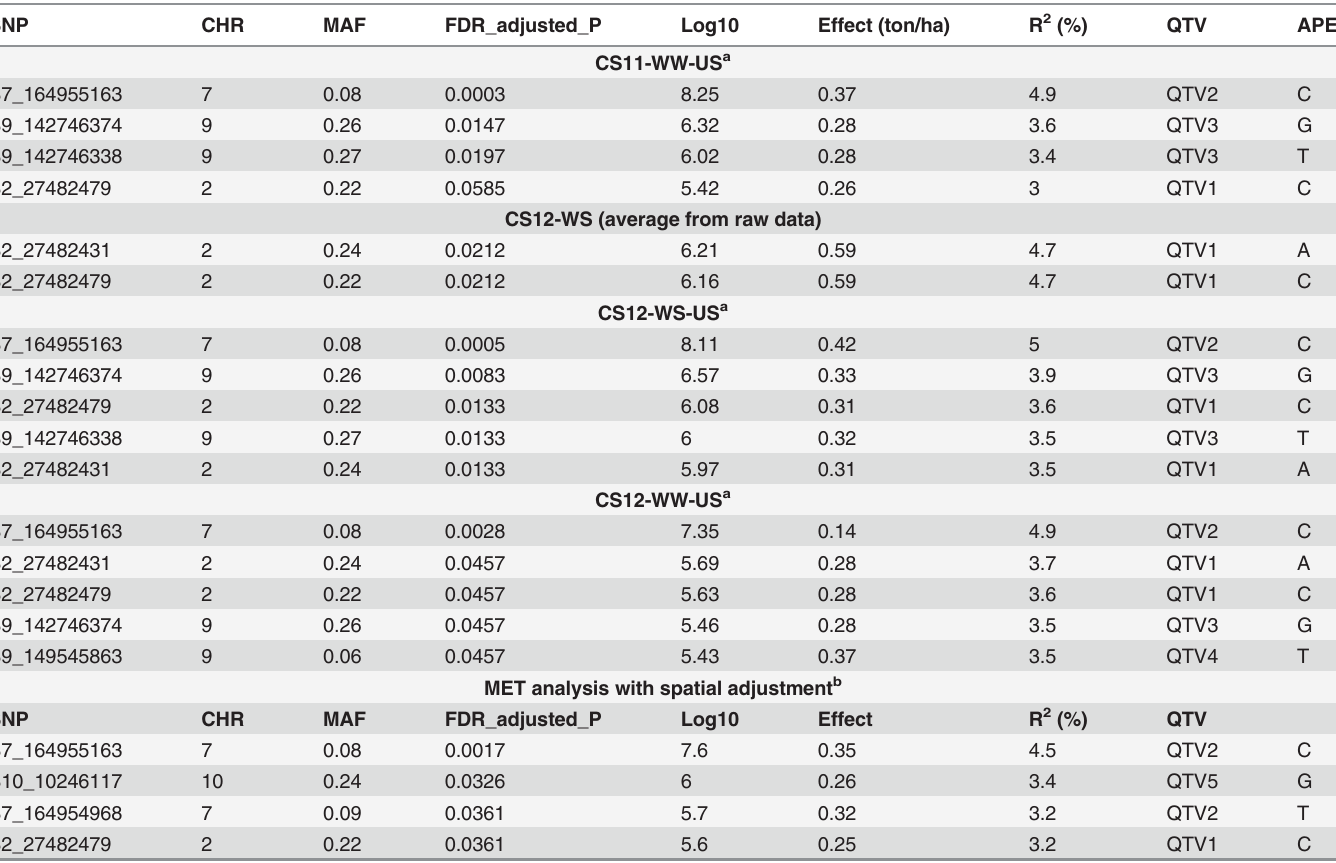
Table 8. GWAS results for grain yield